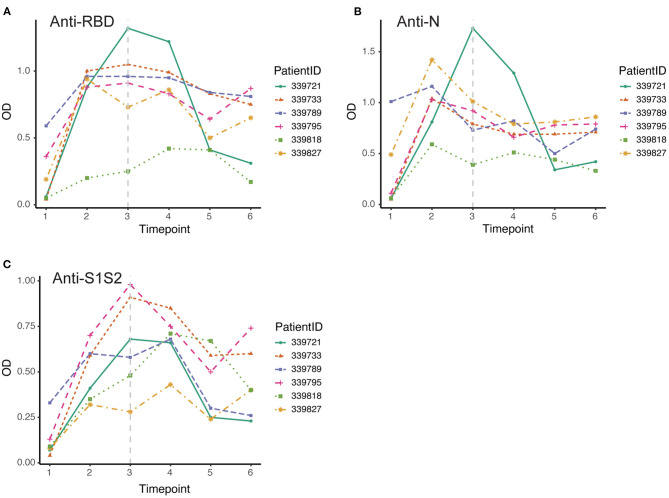
Dynamic changes in antibodies against SARS-CoV-2 structural proteins. (A–C) Dynamic changes in anti-RBD antibody (A), anti-N antibody (B) and anti-S1S2 (C) in representative patients over the monitoring period. Time points 1–6 represent days 1–7, 8–14, 15–28, 29–56, 57–84, and 85–112, respectively, after symptom onset. The gray vertical dashed line indicates the approximate time of discharge.